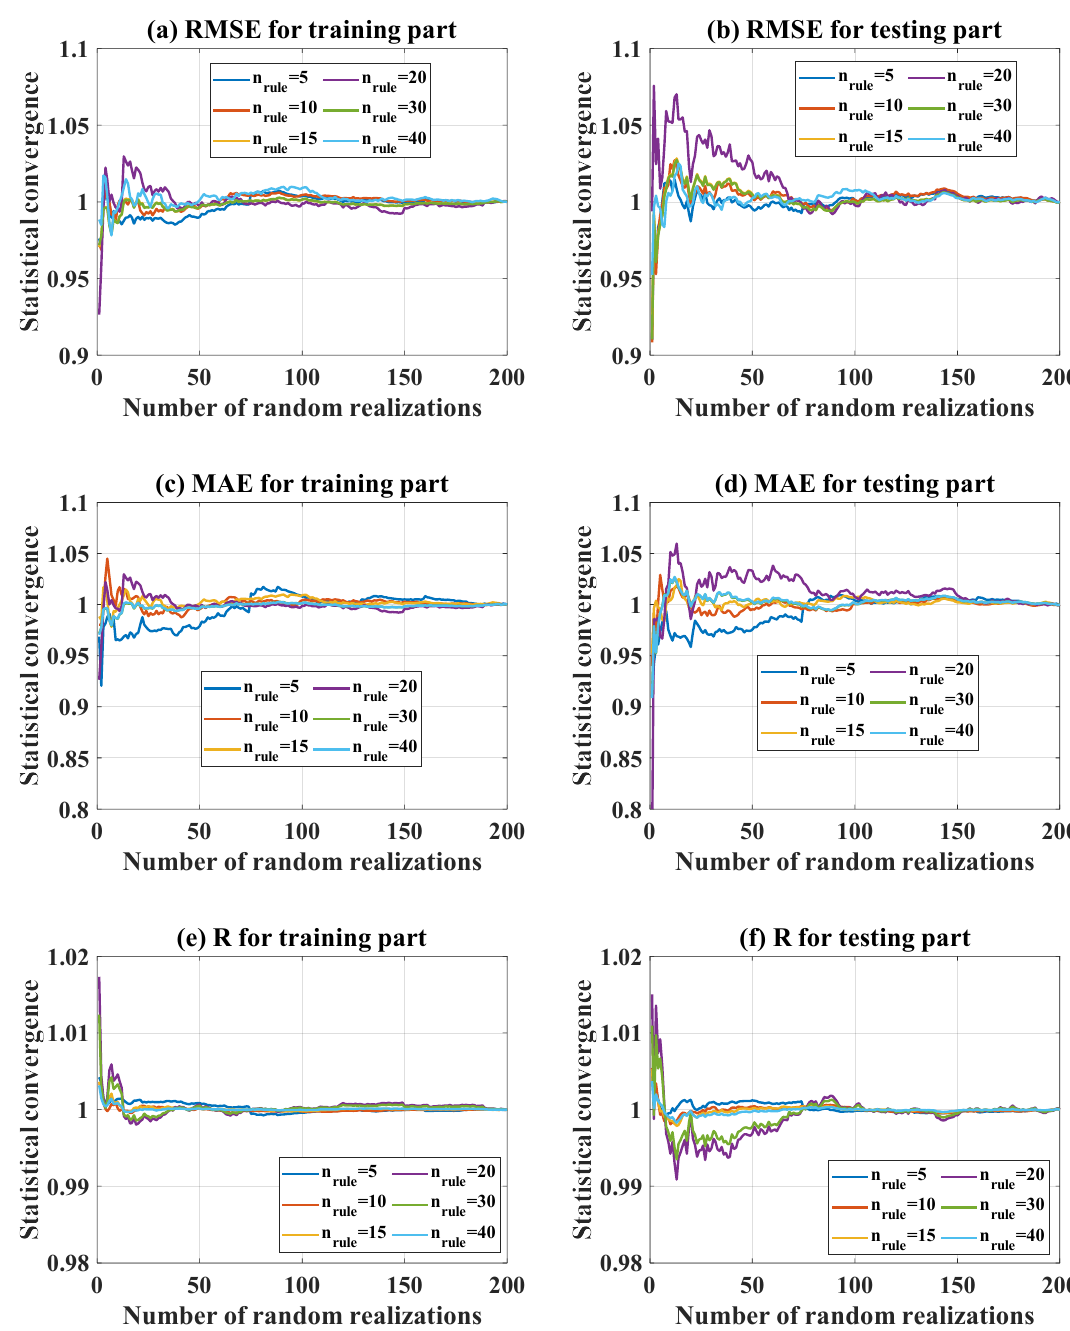
Figure 6. Statistical convergence over 200 random realizations in terms of n rule for the training part: ( a ) RMSE, ( b ) MAE, ( c ) R. Statistical convergence over 200 random realizations in terms of n rule for the testing part: ( d ) RMSE, ( e ) MAE, ( f ) R.